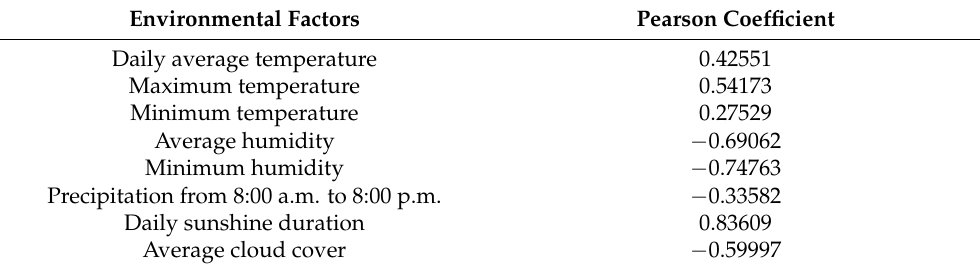
Table 1. Pearson coefficients between environmental factors and generating